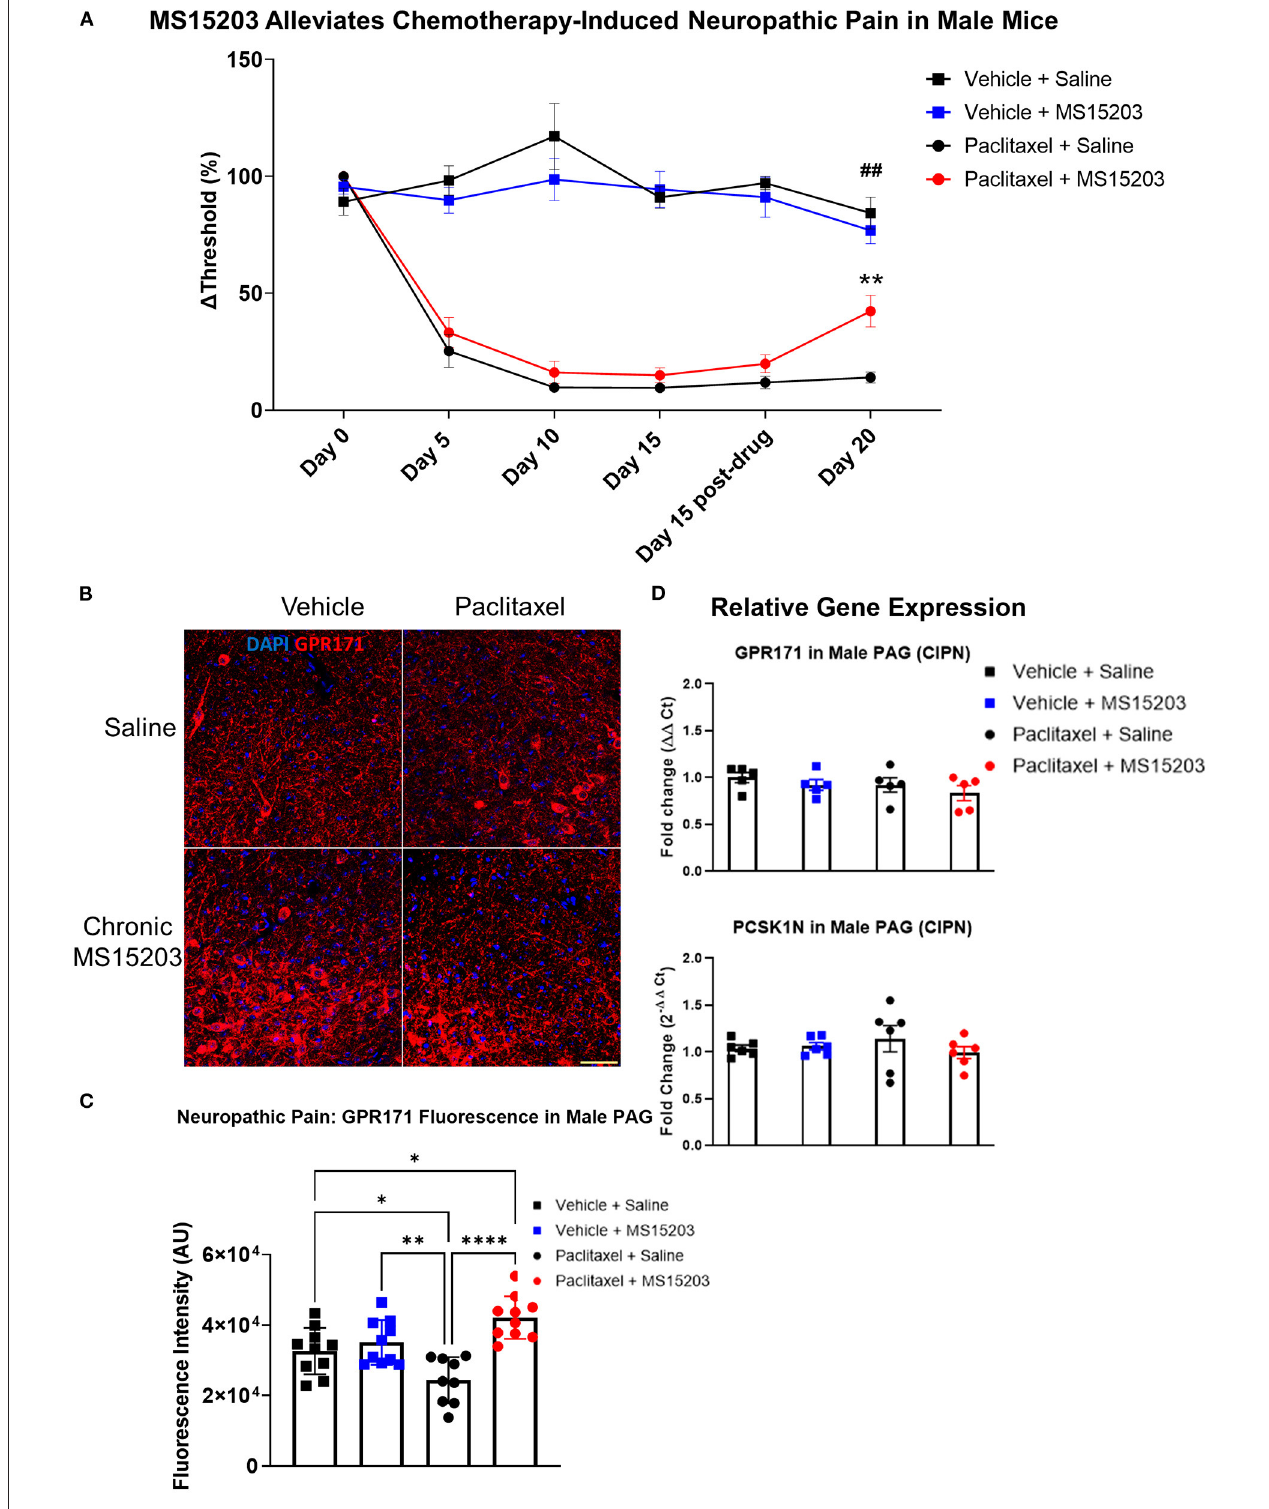
FIGURE 4 | MS15203 reduces chronic neuropathic pain in male mice. (A) Male mice ( n = 6–7/group) treated with paclitaxel (16 mg/kg cumulative, i.p.) developed allodynia by Day 5 of the study as measured by the von Frey test. Chronic, but not acute, treatment with MS15203 alleviated allodynia as noted by the significant increase in mechanical thresholds compared to Paclitaxel + Saline treated mice. Repeated measures two-way ANOVA with Bonferroni’s